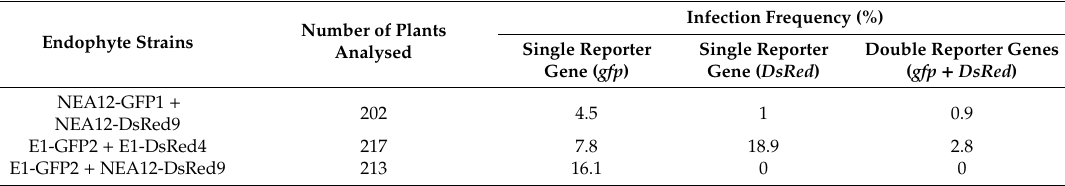
Table 3. Infection frequencies obtained for co-inoculated endophyte strains.